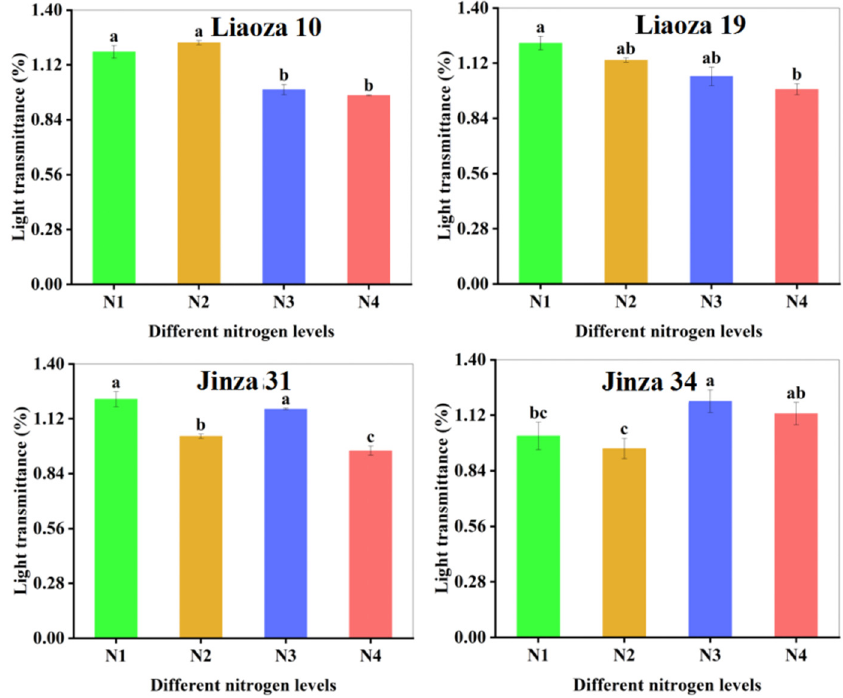
Figure 6. Effects of different nitrogen fertilizer level on the transparency of sorghum starch. Note: values with letters in the figure mean a significant difference ( p < 0.05)